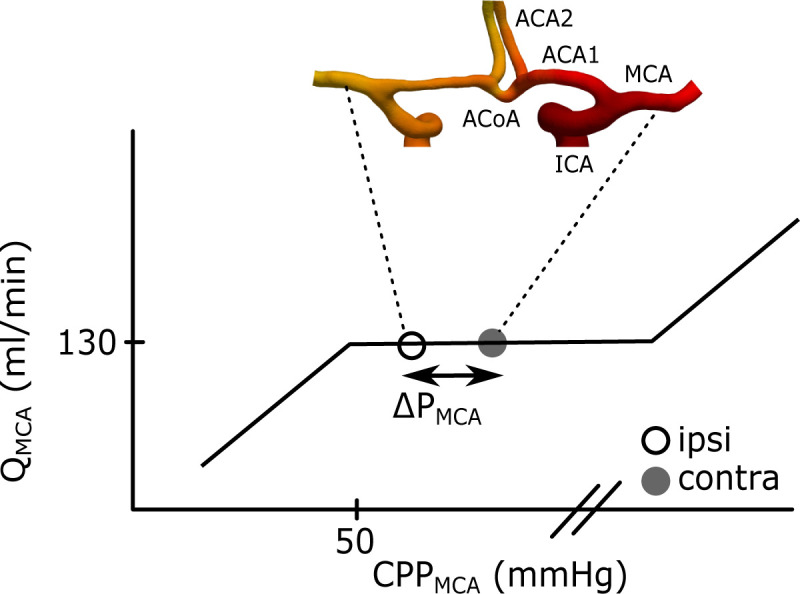
Illustration of the ΔPMCA between the contra- and ipsilateral MCA.The curve corresponds to Lassen’s autoregulation curve and is a schematic relationship between the QMCA and the cerebral perfusion pressure (CPPMCA) in MCA. The CPPMCA is here defined as the mean arterial pressure in MCA minus the intracranial pressure. This means that MCA should have a maintained flow within a range of perfusion pressures at the MCAs. The separation between the contra- and ipsilateral CPPMCA was defined as ΔPMCA. The geometry is an example of the anterior part of CW. Left and right ICA branches into the left and right MCA and ACA1. The two ACA1s is connected by the ACoA before they branch into the left and right ACA2. The posterior circulation is not displayed in the figure, but the anterior and the posterior part is connected via the posterior communicating arteries.